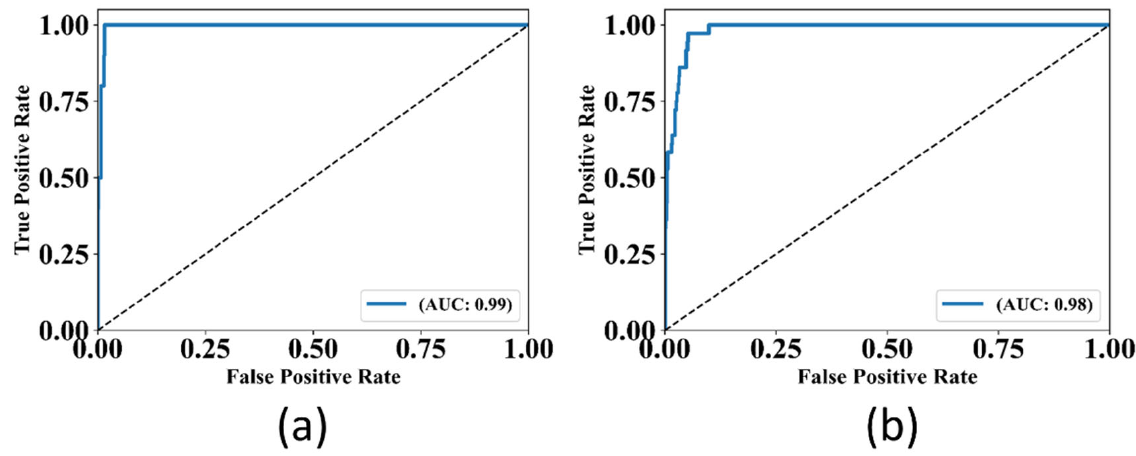
Figure 15. AUC and ROC Curves for ( a ): UNet model, ( b ): UNet+ model ( p < 0.0001).